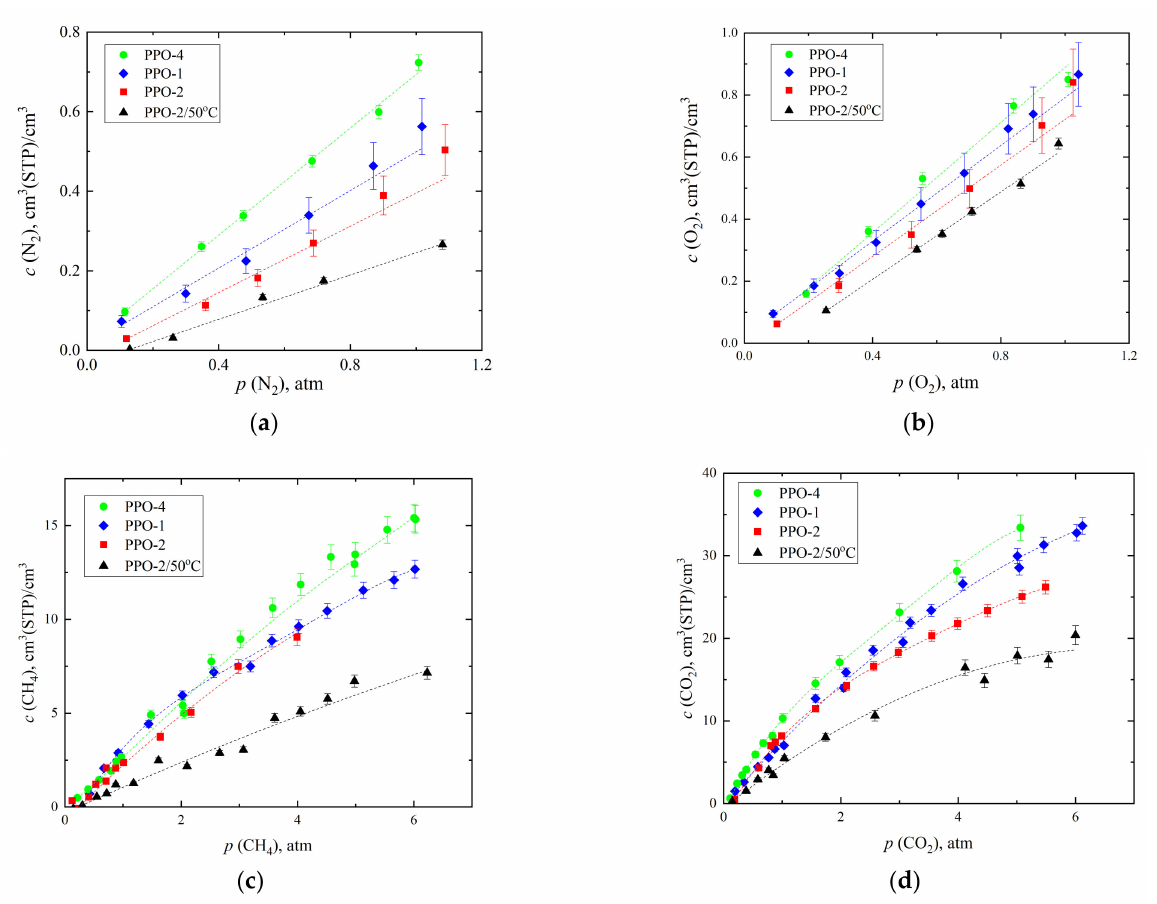
Figure 6. Sorption isotherms of N 2 ( a ), O 2 ( b ), CH 4 ( c ), and CO 2 ( d ) obtained by the volumetric method with chromatographic detection for PPO-2/50 ◦ C, PPO-1, PPO-2, and PPO-4 film